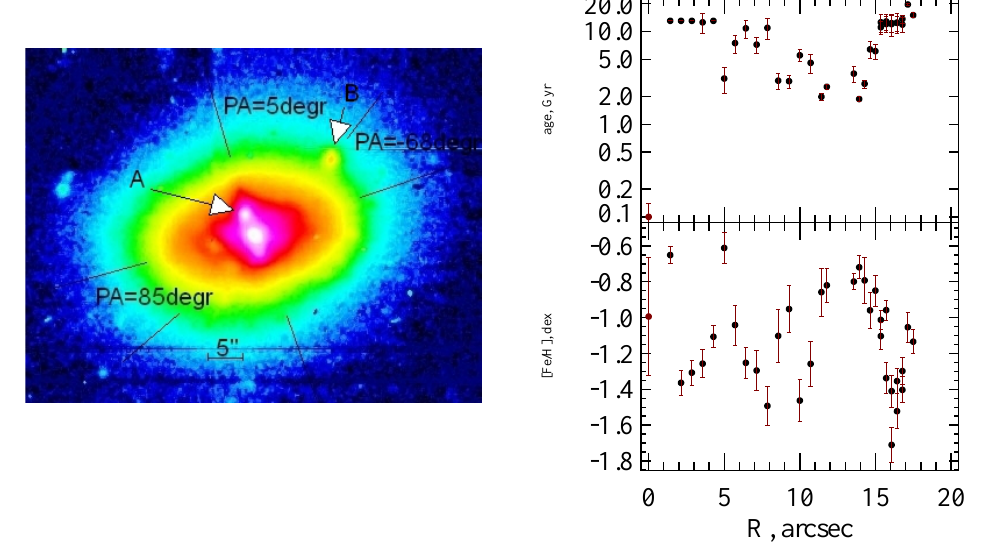
Figure 2. Left : The image of UGC 1198 in B -band taken from: http://www.astro.spbu.ru/PolarRing/ prg.html. The positions of the slit during our observations are shown. Arrows indicate the “A” and “B” objects discussed in the paper. North is up and east is to the left. 1 (cid:48)(cid:48) corresponds to 0.9 kpc, H 0 = 72 km/s/Mpc . Right : Dependences of age ( top ) and metallicity ( bottom ) of the stellar population of UGC 1198 on distance along PA = − 68 ◦